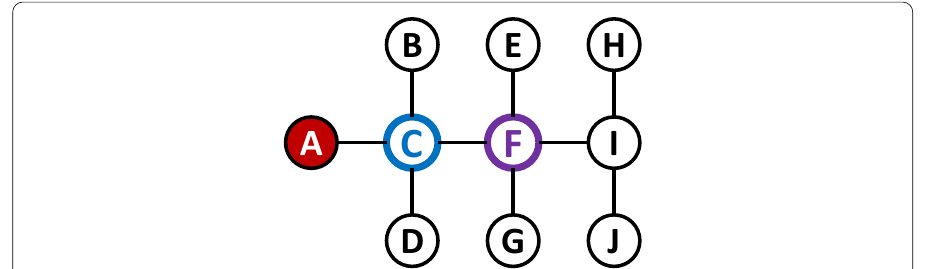
Fig. 3 A comparison between Infectious Betweenness Centrality and Betweenness Centrality for the network from Fig. 1 and a single infected node ( A ). The node with the blue outline ( C ) has the highest Infectious Betweenness Centrality score, whereas the node with the purple outline ( F ) has the highest Betweenness Centrality score